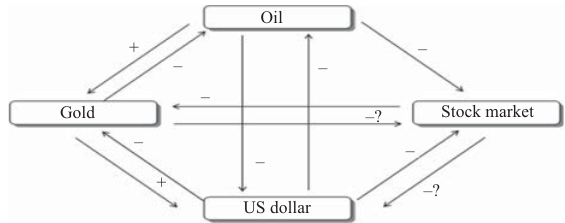
Figure 1. Direct and indirect relationships: evidence from the